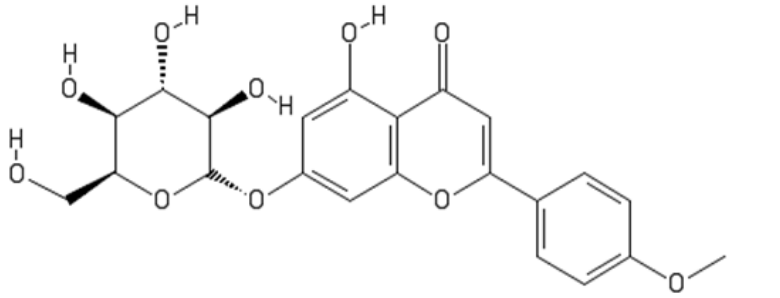
Figure 1. The chemical structure of tilianin. Tilianin is one of the major bioactive compounds in Agastache rugosa extract.